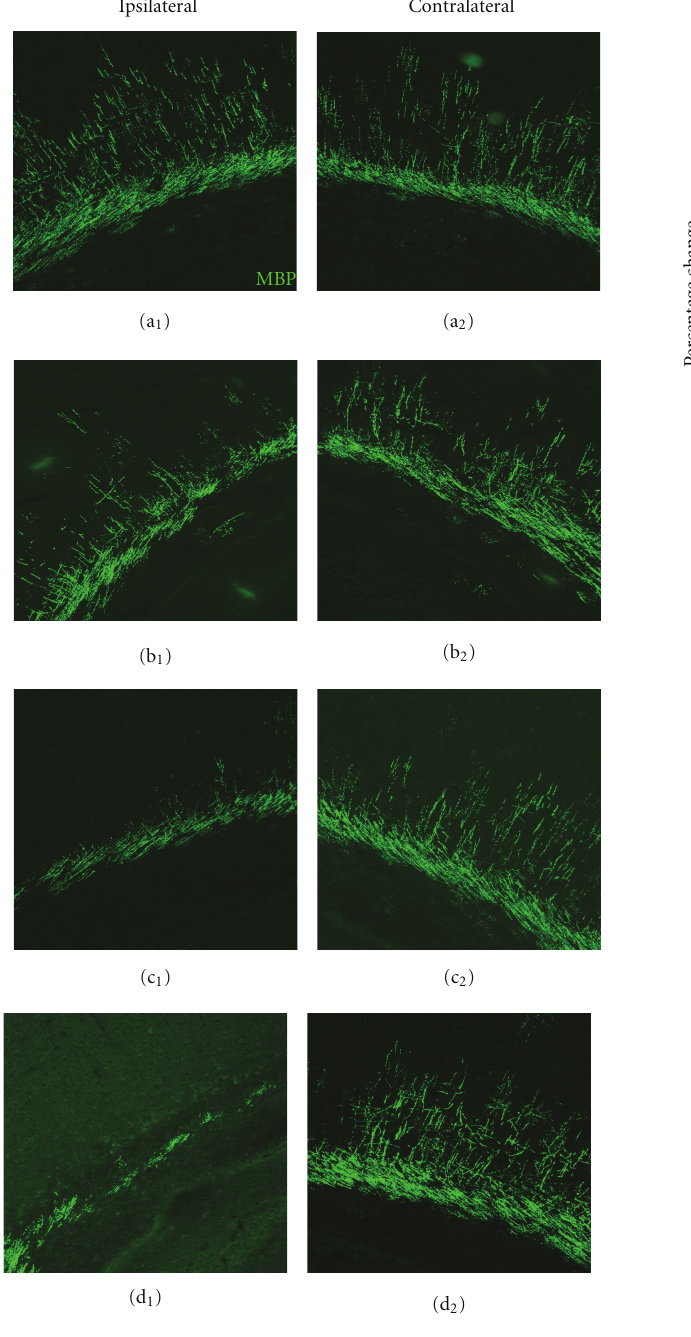
Figure 1: Periventricular white matter loss following hypoxia-ischemia (HI) in postnatal day 6 (P6) rats. Seventy-two hours following HI at P6, myelin basic protein (MBP) is significantly depleted in the hemisphere ipsilateral to carotid ligation. Representative photomicrographs show MBP in hemispheres both ipsilateral (a 1 –d 1 ) and contralateral (a 2 –d 2 ) to carotid ligation in animals with Grade 0 MBP loss (no discernable white matter injury, a 1 -a 2 ), Grade 1 MBP loss (mild white matter injury, b 1 -b 2 ), Grade 2 MBP loss (moderate white matter injury, c 1 -c 2 ), and Grade 3 MBP loss (severe white matter injury, d 1 -d 2 ). Histogram shows average percent change in MBP for each group